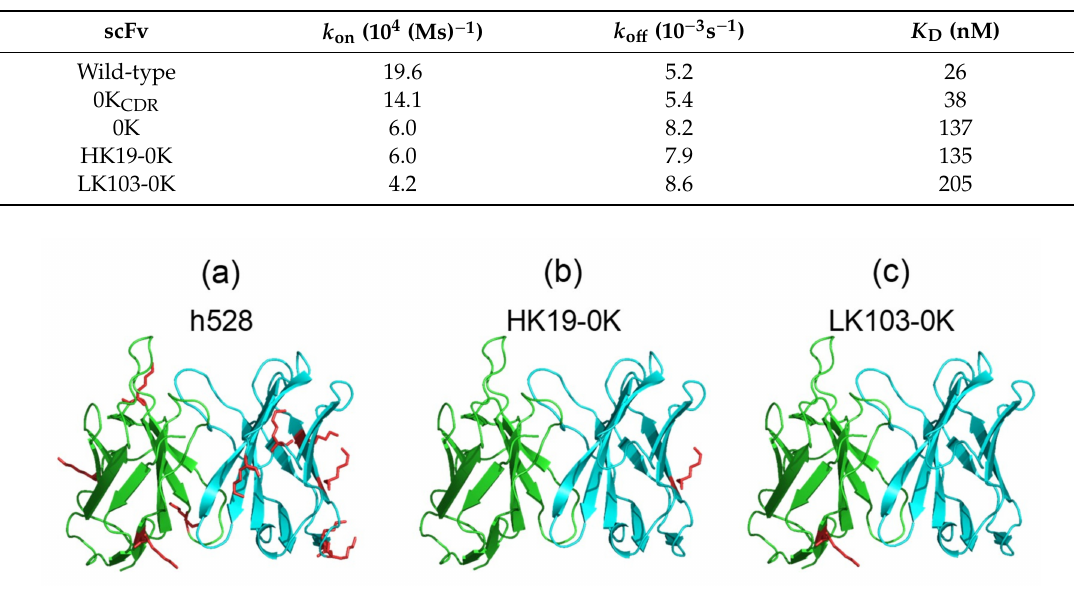
Figure 1. Lysine positions on ( a ) h528 scFv, ( b ) HK19-0K h528 scFv where all lysines were mutated except for HK19, and ( c ) LK103 0K h528 scFv where all lysines were mutated except for LK103. Green-colored and blue-colored domains are VL and VH domains, respectively, and red-colored residues are lysine. PDB code of the used crystal structure used is